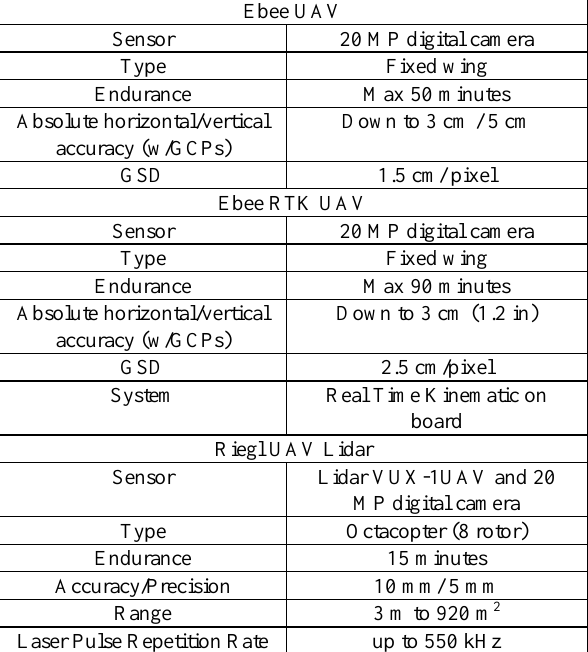
Table 1. Specification of UAV systems used for data